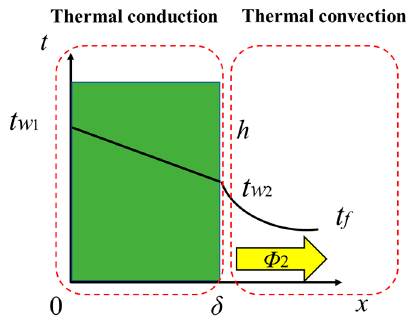
Figure 1. Thermal transfer.